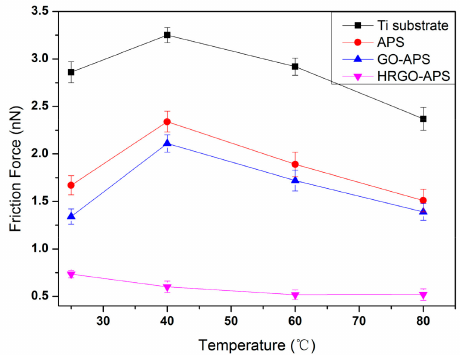
Figure 17. Variation of friction forces of hydroxylated Ti substrate and prepared coatings under various temperatures (applied load: 70nN; Scan area: 2 µ m × 2 µ m; scan speed: 2